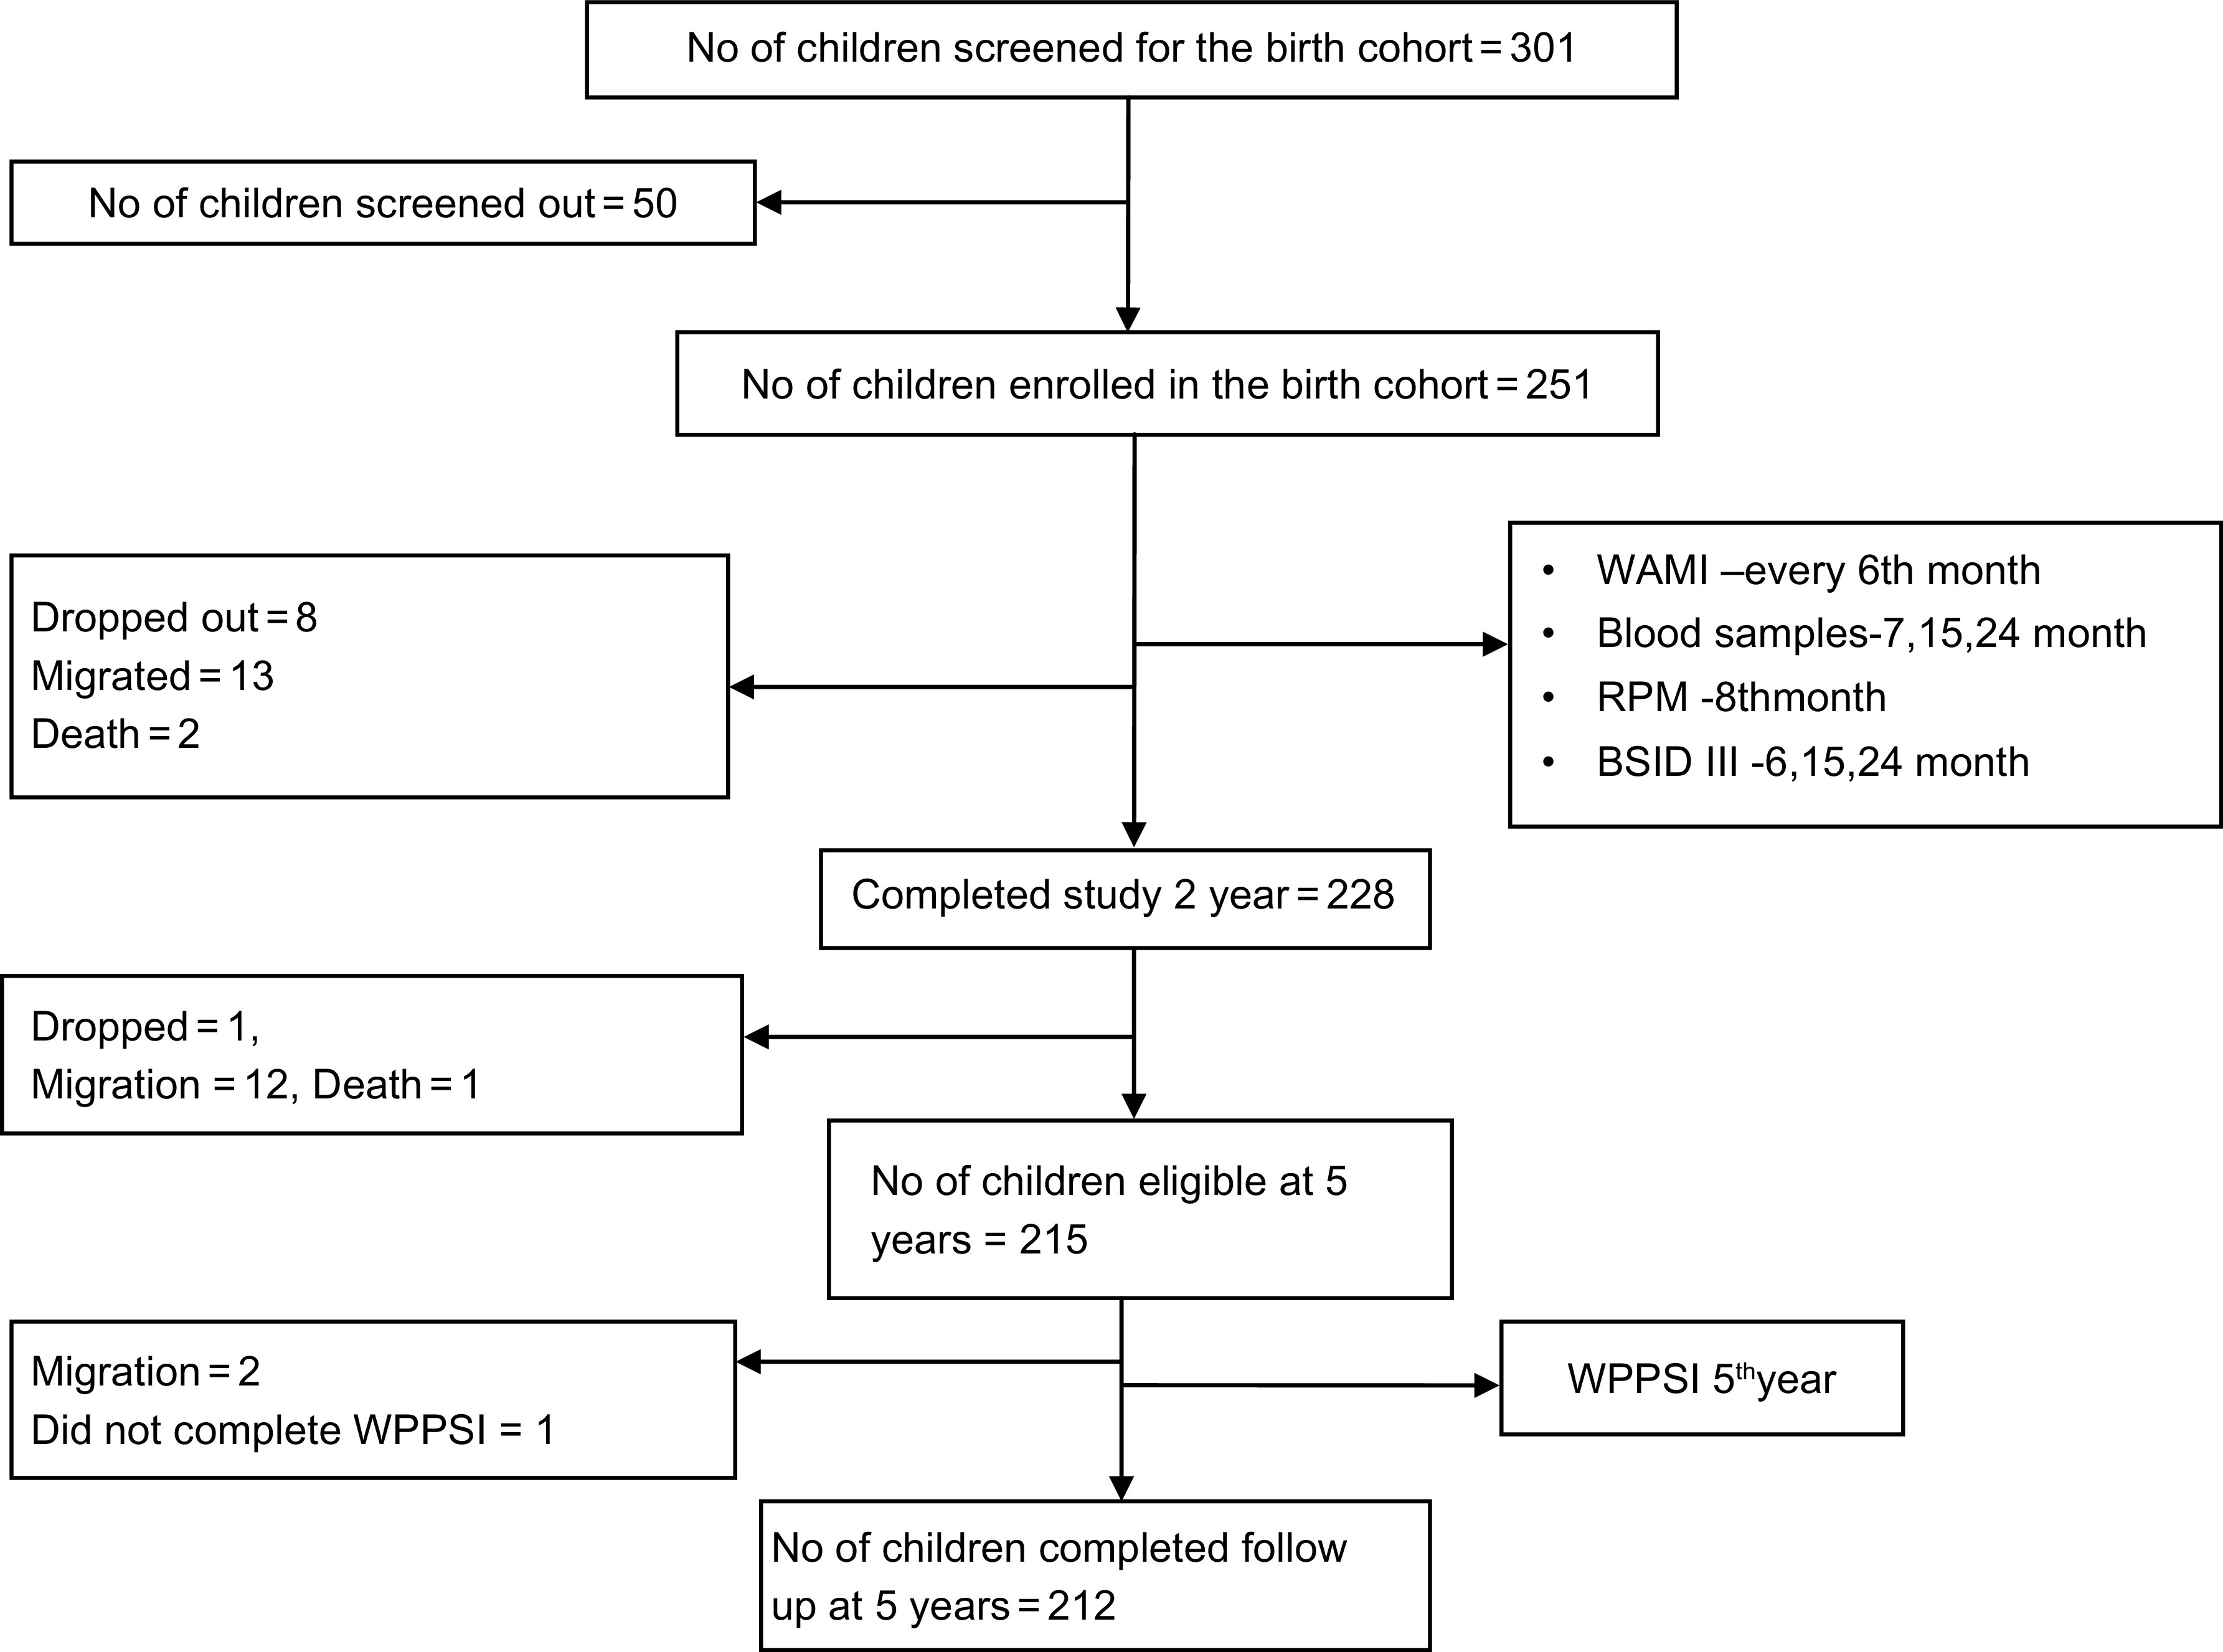
Flow chart depicting the follow-up of the birth cohort. WAMI, Water and sanitation, Assets, Maternal education and Income score for socio-economic status; RPM, Raven’s progressive matrices; BSID III, Bayley Scales of Infant and Toddler Development III; WPPSI III, Wechsler Preschool Primary Scales of Intelligence